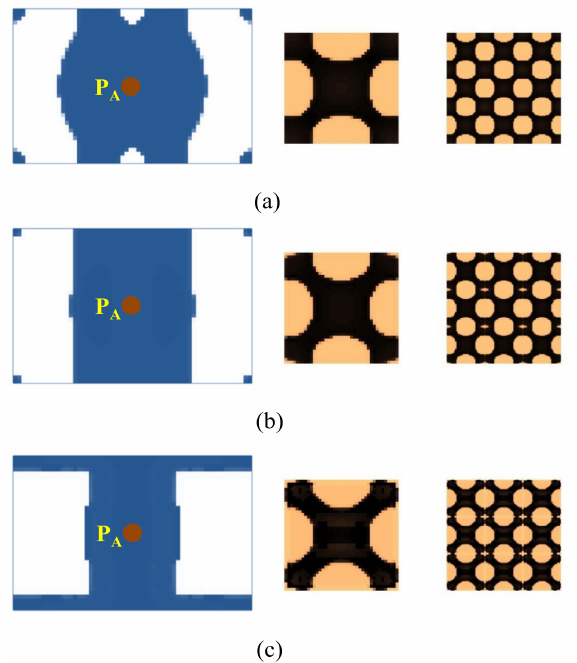
Figure 21. Design results obtained by varying the excitation frequency at the excitation position P A .